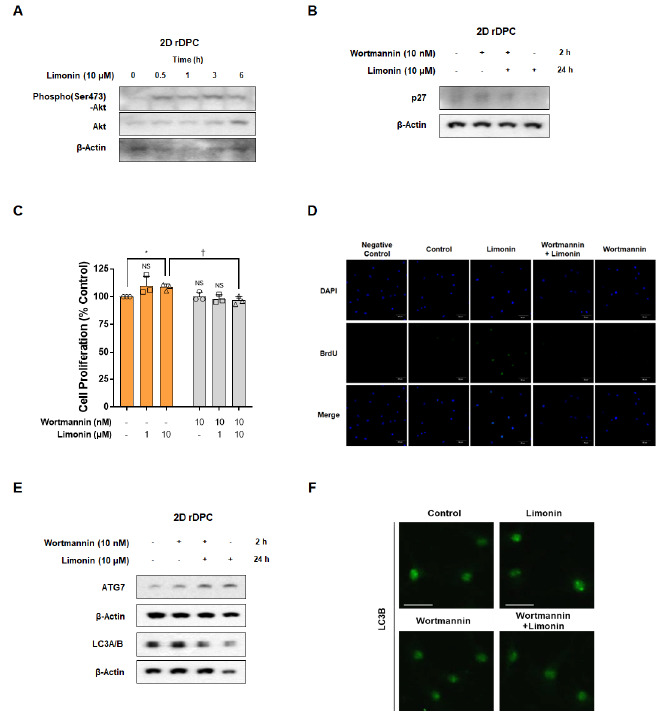
Figure 4. Limonin induces cell proliferation through activation of the autophagy pathway via PI3K/AKT signaling in two-dimensional (2D) cultured rDPC. ( A ) Representative images of Western blots for phospho(Ser473)-AKT after treatment with limonin for 0–6 h. ( B ) Representative images of Western blots for p27 after treatment with limonin for 24 h in the absence or presence of wortmannin. ( C ) Changes in the proliferation of 2D dermal papilla cells after treatment with limonin for 3 days with or without wortmannin. ( D ) Confocal microscopy images for changes in the number of BrdU- positive cells after treatment with limonin for 24 h with or without wortmannin. ( E ) Representative images of Western blots for ATG7 and LC3A/B after treatment with limonin for 24 h with or without wortmannin. ( F ) Confocal microscopy images of changes in the number of LC3B puncta after treatment with limonin for 24 h with or without wortmannin. * p < 0.05 vs. vehicle-treated control. † p < 0.05 vs. limonin alone. Scale bars, 50 µ m. NS, not